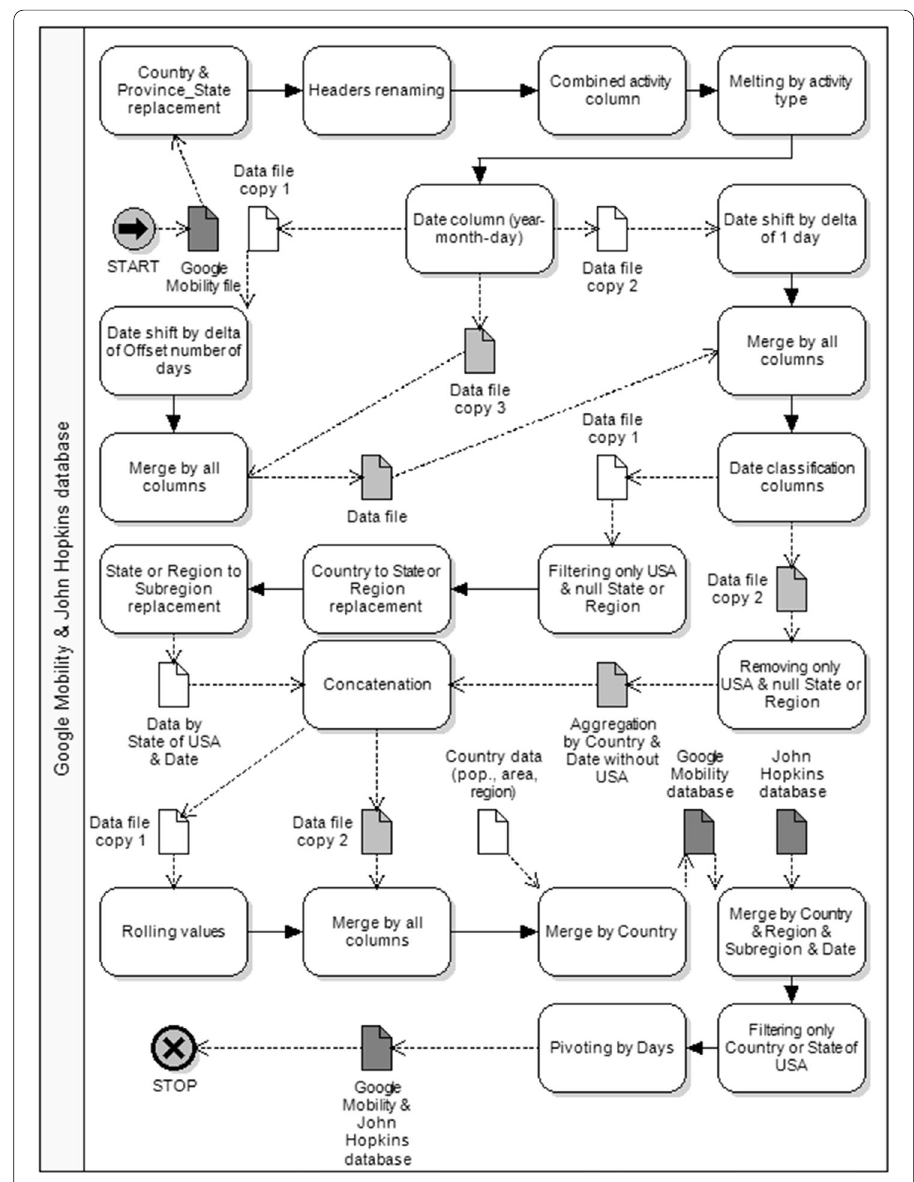
Fig. 3 Google Mobility and John Hopkins University data processing